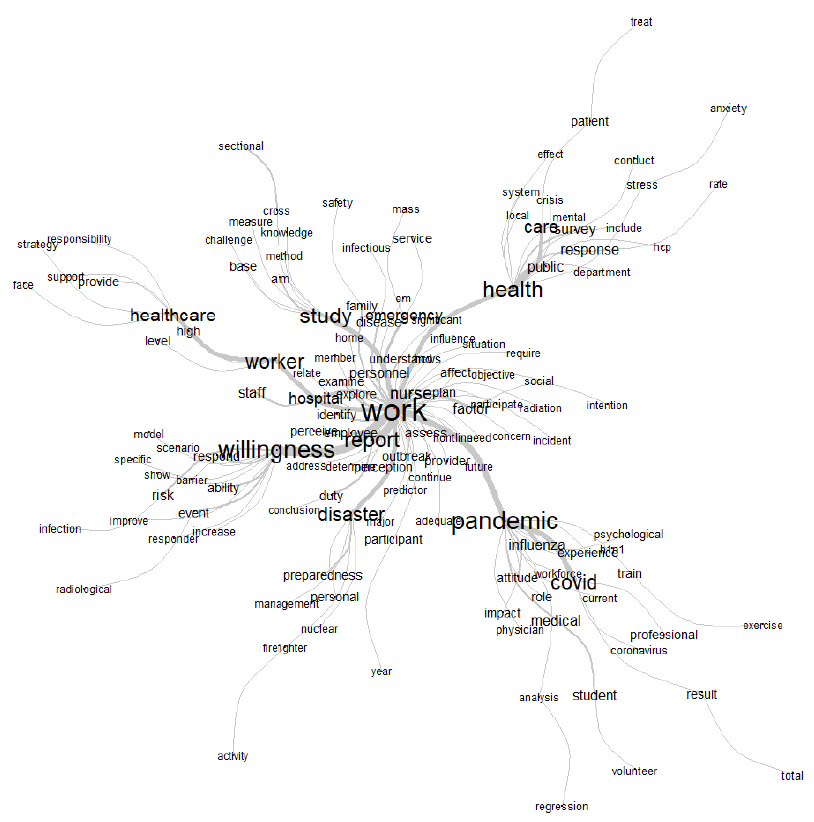
Figure 6. Most frequent expressions. Table 8. Thematic evolution per year: 5 most frequent themes per year of publication.